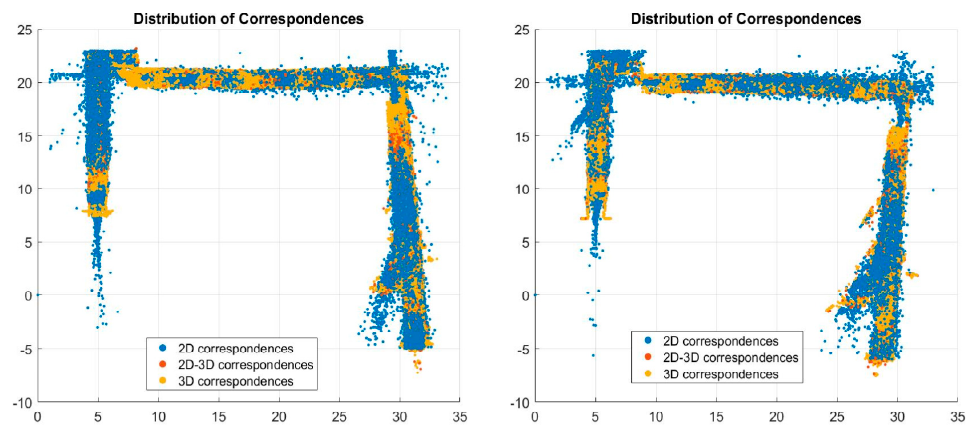
Figure 13. Distribution of correspondences of corridor scenes.